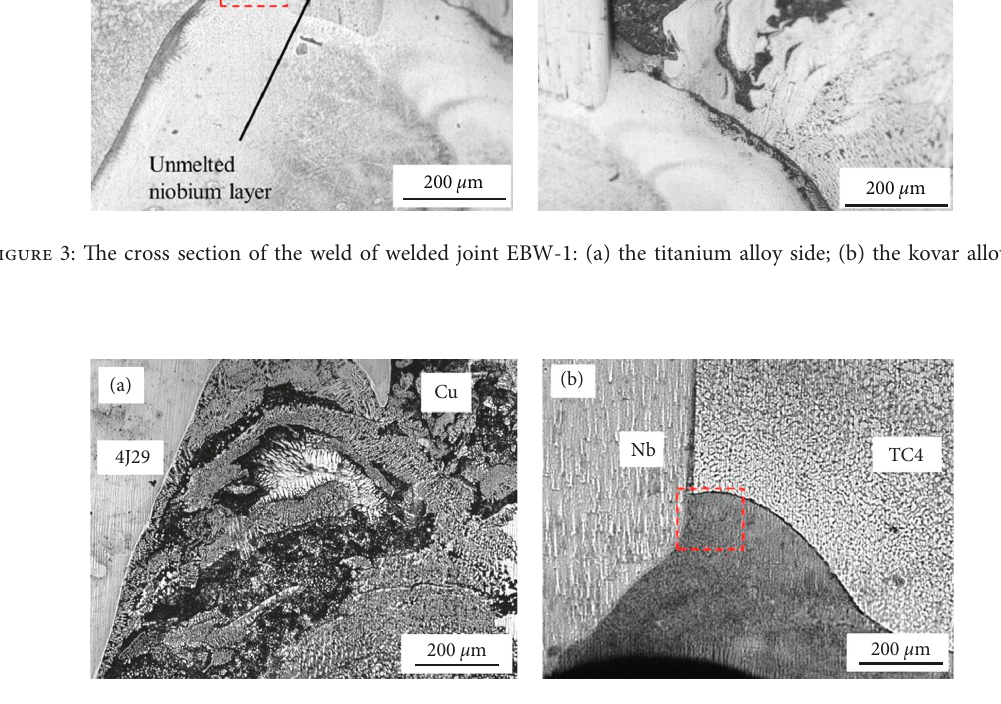
Figure 4: The cross section of the weld of welded joint EBW-2: (a) the kovar alloy side; (b) the titanium alloy